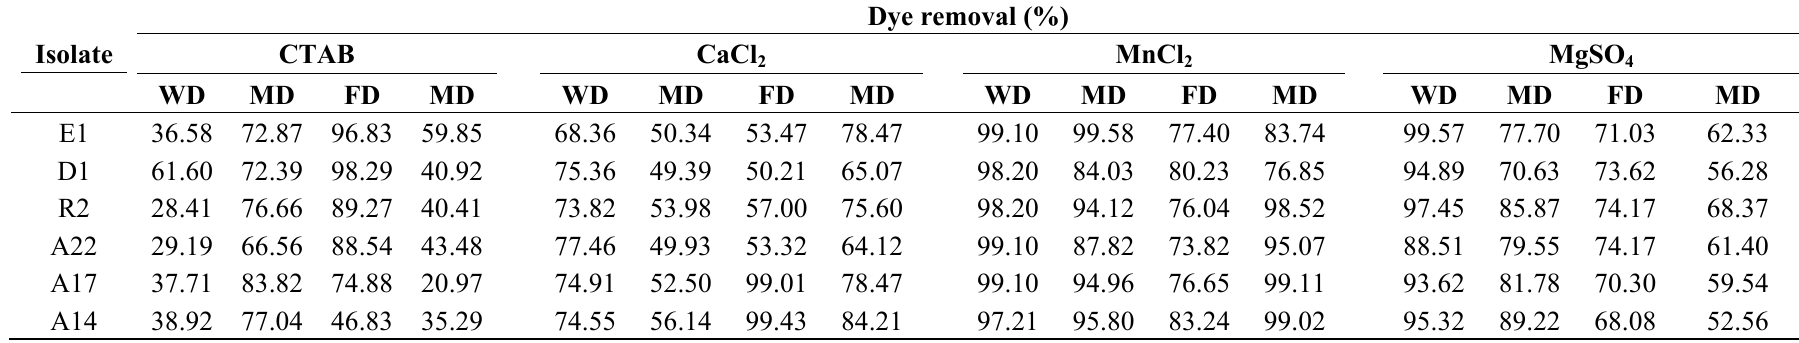
Table 2. Effects of cations a on the removal of dyes from the wastewater effluents by the bacterial bioflocculants at 10 ppm concentration.